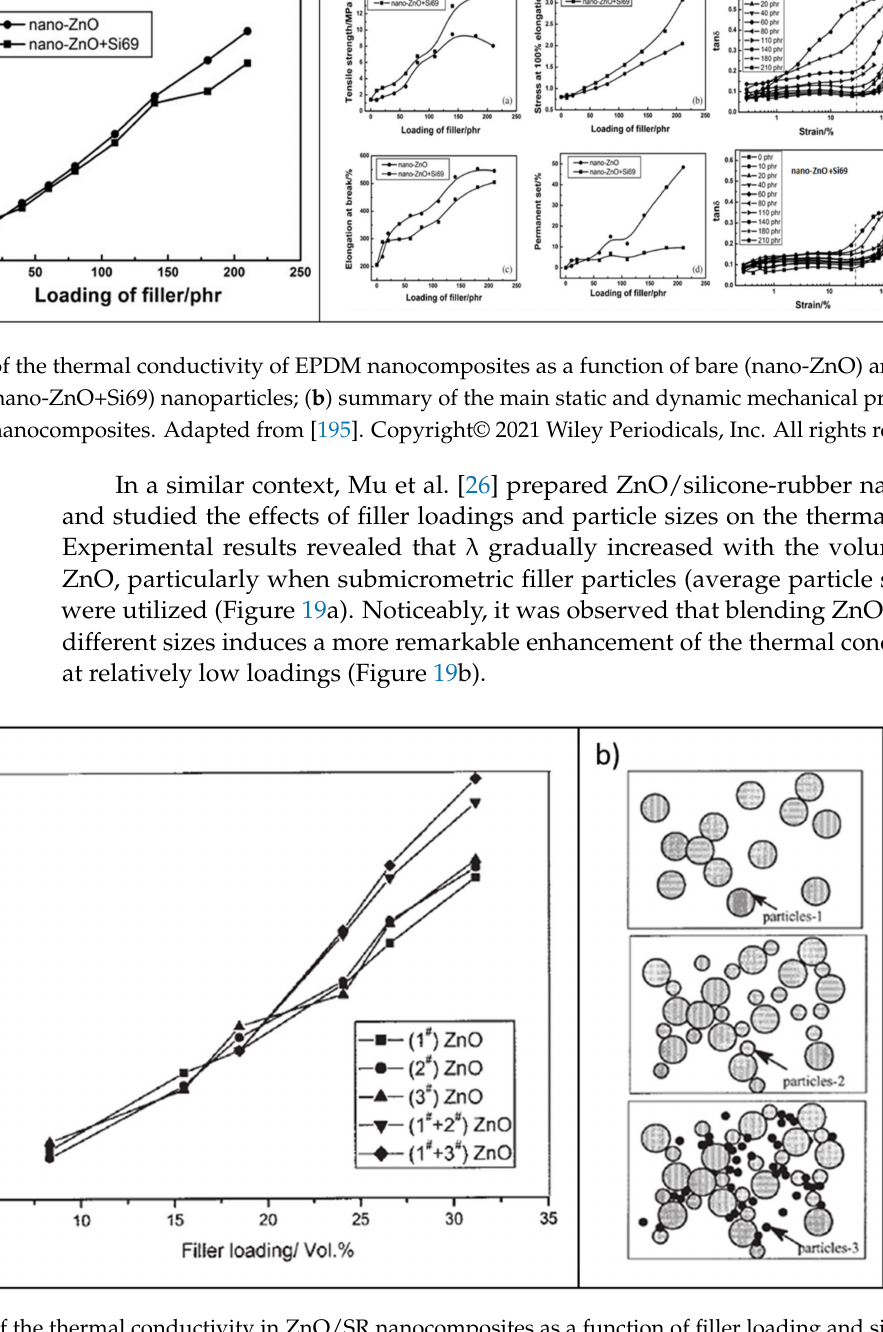
Figure 19. ( a ) Trend of the thermal conductivity in ZnO/SR nanocomposites as a function of filler loading and size (1 # ZnO, 2 # ZnO, 3 # ZnO); ( b ) Sketch of the thermal conduction models for silicone rubber enclosing a single filler or ZnO particles with different sizes. Adapted from [26]. Copyright© 2018 Wiley Periodicals, Inc. All rights